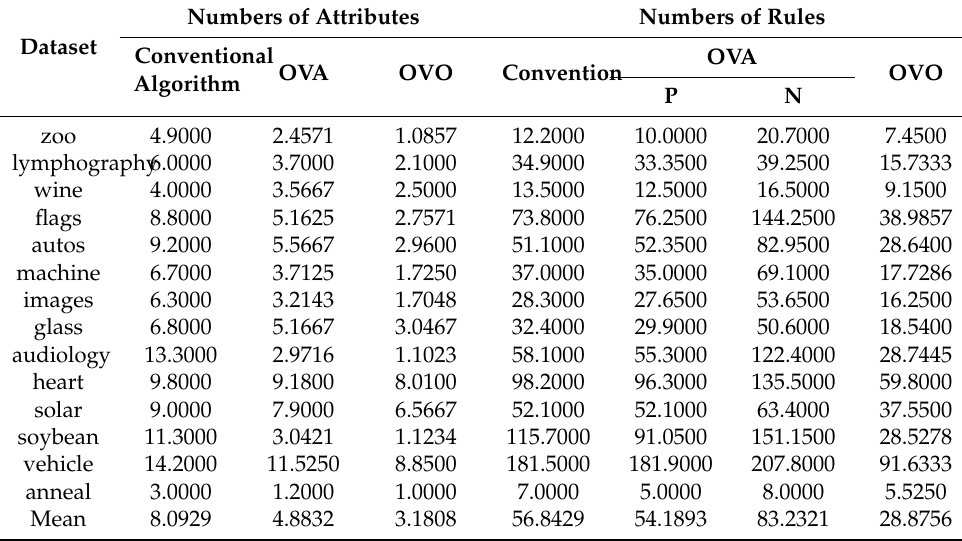
Table 4. Numbers of attributes and rules obtained by different